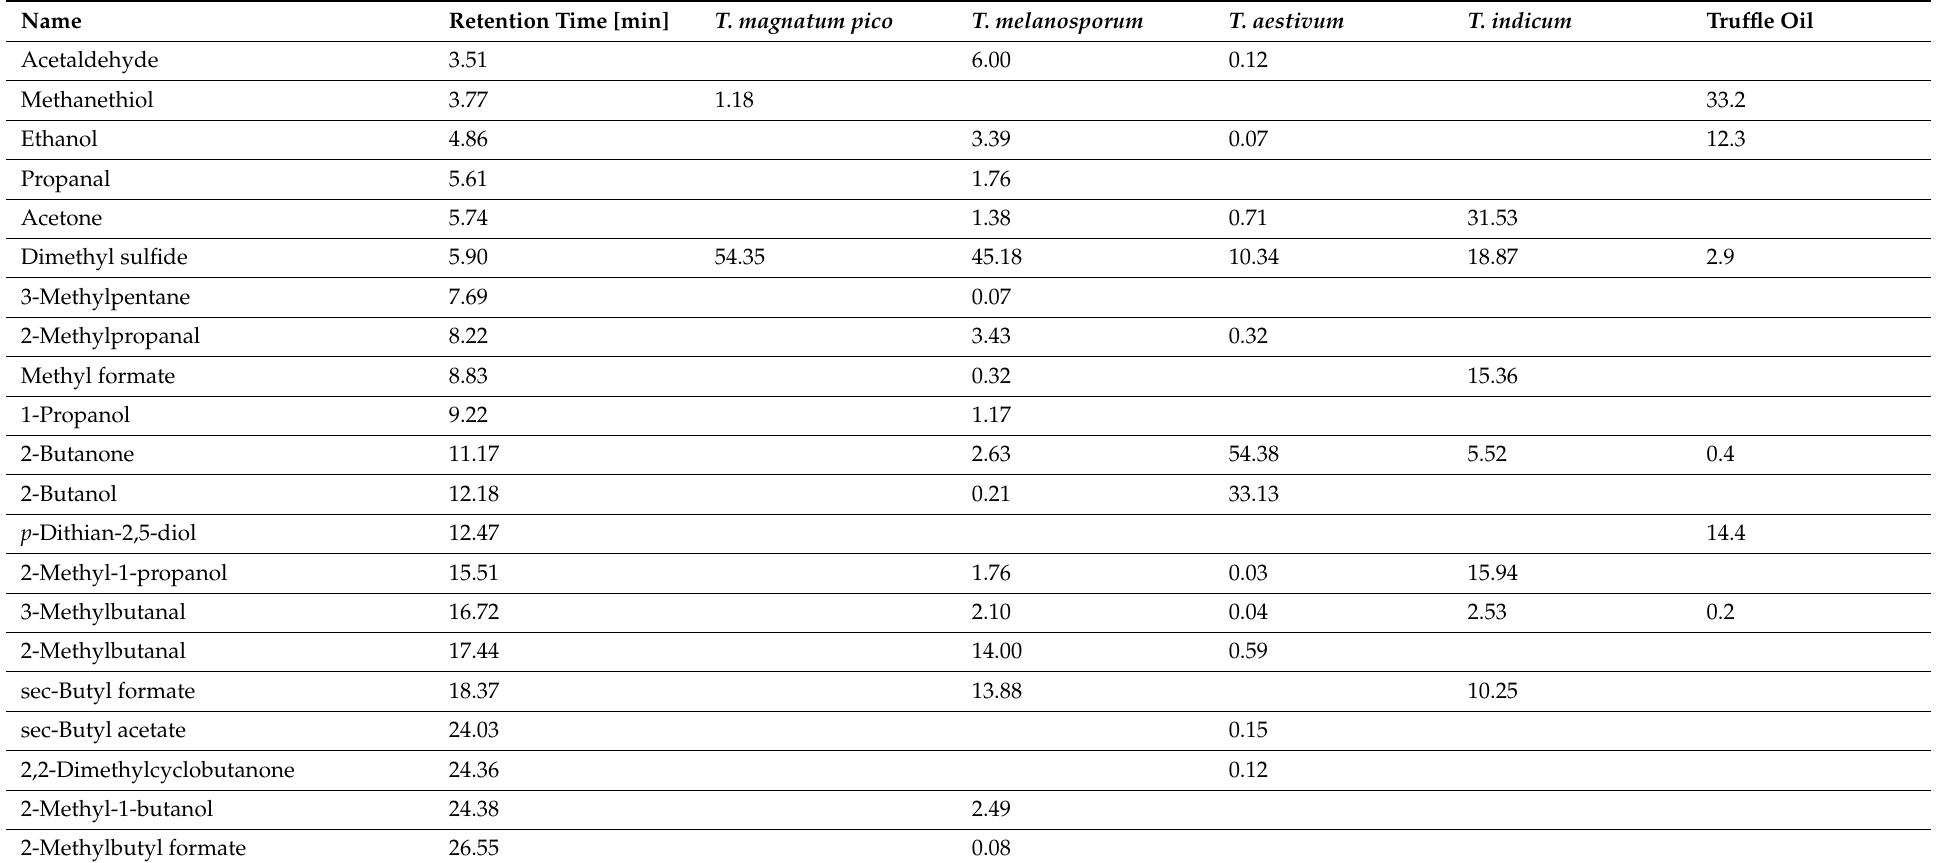
Table A1. Identified aroma substances from SHS/GC-MS measurements as peak area percentages from entire